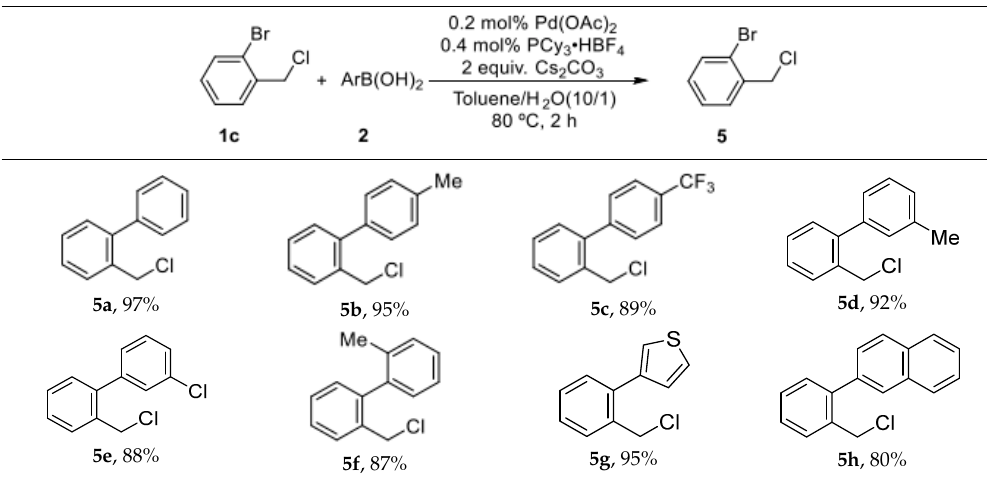
Table 4. Selective coupling reaction of arylboronic acid with 1-bromo-2-(chloromethyl)benzene a.